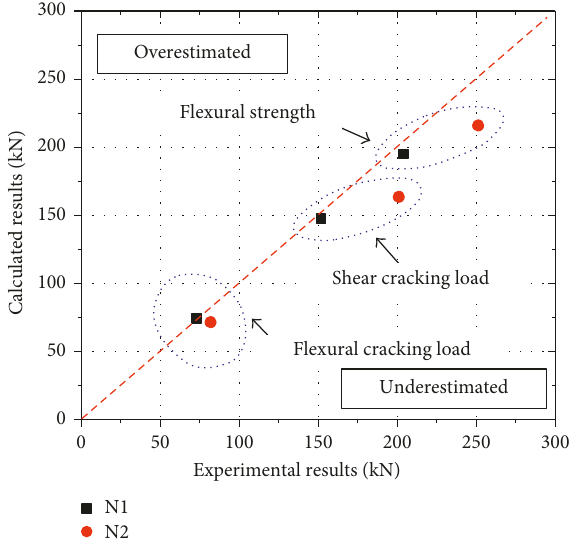
Figure 26: Comparison of experimental and calculated